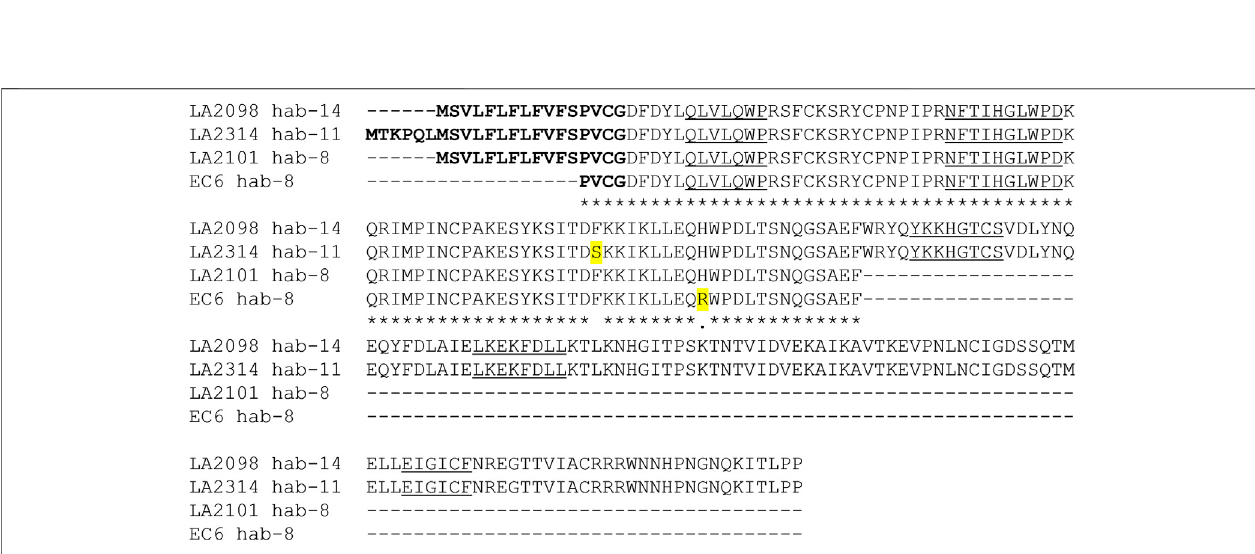
FIGURE 5 | Amino acid sequence of S. habrochaites SC-associated hab-8 S-RNase aligned with amino acid sequence of SI-associated hab-14 and hab-11 S-RNases. Predicted amino acids of hab-8 S-RNase (GenBank OK091160) from SC accessions LA2101 and EC6 are aligned with predicted hab-14 sequences (GenBank OK091163) from SI individuals from mixed SI/SC accession LA 2098 (an identical sequence was recovered from SI accession LA2864, not shown) and hab- 11 in LA2314 (identical to partial codon sequence of hab-11 in accession LA0094, GenBank MW183817, not shown). The predicted signal peptide is bolded, amino acid substitutions are highlighted in yellow and conserved sequences C1-C5 are underlined. Asterisks indicate conservation between all sequences.